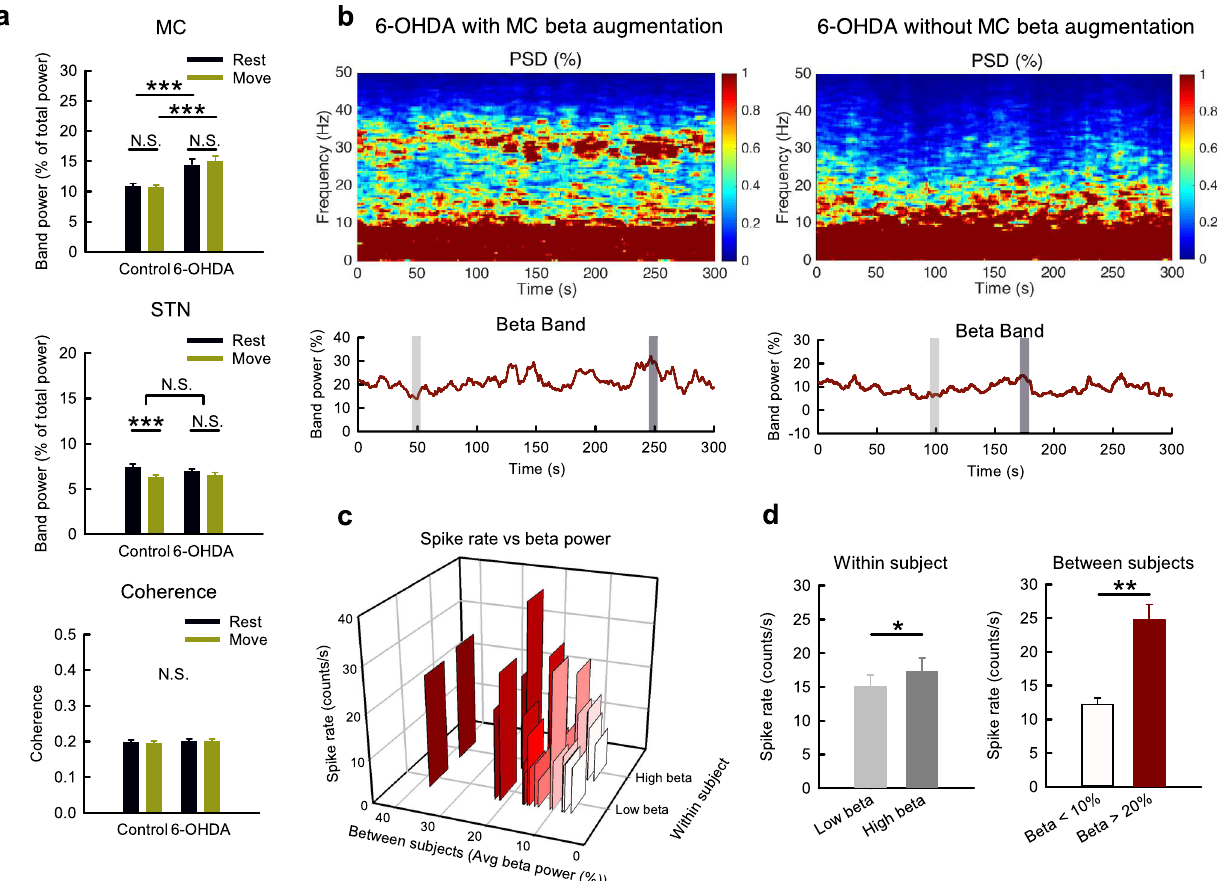
Fig. 4 The association of MC β augmentation with higher spike activities but not locomotor activities in parkinsonian rats. a β band power analysis from the 10-s segments in Figs. 2, 3 ( n = 52 and 50 matched segments of rest and movement from 10 control and 11 parkinsonian rats, respectively). b – d Power spectrograms (tops) and the temporal changes of MC β band powers (bottoms) from sample recordings demonstrate the typical presentation of parkinsonian rats with MC β augmentation or not ( b , left and right, respectively). Among the 20 continuous 5-min recordings from 11 parkinsonian rats, a peak in β range frequency was noted in 9 recordings (45%) but not in the other 11 recordings (55%). Each recording was further divided into two 10-s segments, with highest (dark gray bar) or lowest (light gray bar) β band power, as the high β group ( “ High beta ” ) and low β group ( “ Low beta ” ), respectively, for multi-unit analysis. The 3D-bar plot reveals average spike rates from 7 leads grouping according to the level of β power in each recordings of parkinsonian rats, and shows that higher β power is associated with a higher spike rate in both within-subject comparison and between-subject comparison ( c ). There is a signi fi cant higher MC MU spike rate in “ High beta ” group than in “ Low beta" group ( n = 17 from 8 parkinsonian rats) ( d , left). There is also a higher spike rate in recordings with extreme β augmentation (average β power > 20%) than in recordings with scarcity of β (average β power < 10%), n = 4 from 2 rats in both groups (each group had n = 8 segments from “ High beta ” and “ Low beta ” groups) ( d , right). Data were presented as mean ± S.E.M. Data in ( a ) were analyzed with 2 × 2 mixed model ANOVA and simple main effect tests for pairwise comparison. Each horizontal line reports the simple main effect, and each square bracket reports the main effect of control vs. 6-OHDA in ANOVA. The data in the right and left panels in ( d ) were analyzed with Mann – Whitney U tests and Wilcoxon signed-rank tests, respectively. * p < 0.05, ** p < 0.01, *** p < 0.001, N.S., nonsigni fi